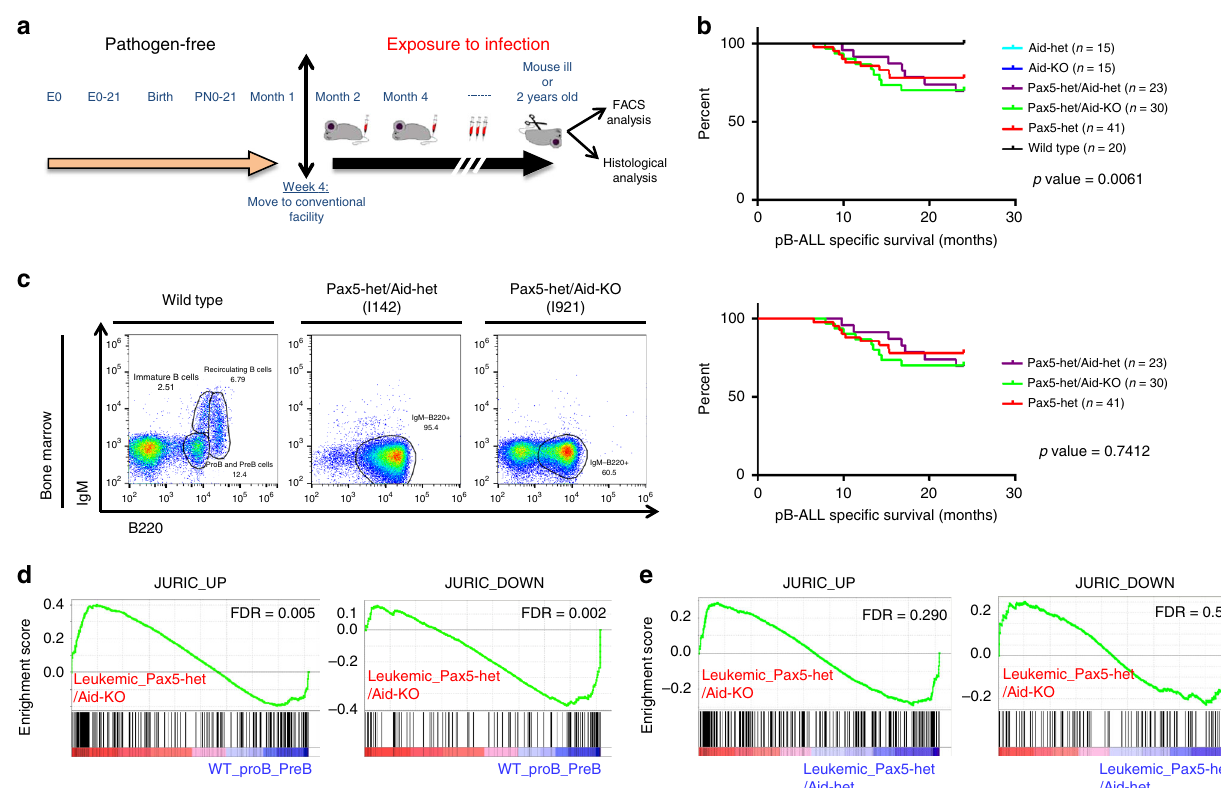
Fig. 1 Contribution of AID to the genesis of native infection-driven B-ALL. a Experimental design. Mice permanently kept either in a SPF animal house during their lifespan or transferred to natural infection exposure between 4 and 5 weeks after birth. b Comparison between B-ALL-speci fi c survival of Aid- het mice (light blue, n = 15), Aid-KO mice (deep blue, n = 15), Pax5-het/Aid-het mice (violet, n = 23), Pax5-het/Aid-KO mice (green, n = 30), Pax5-het animals (red, n = 41), and WT control mice (black, n = 20). Pax5-het/Aid-het or Pax5-het/Aid-KO mice showed a signi fi cantly shortened lifespan (log-rank p- value = 0.0061) (upper panel) that was similar to the Pax5-het group (lower panel) (log-rank p- value = 0.7412). c Flow cytometric analysis